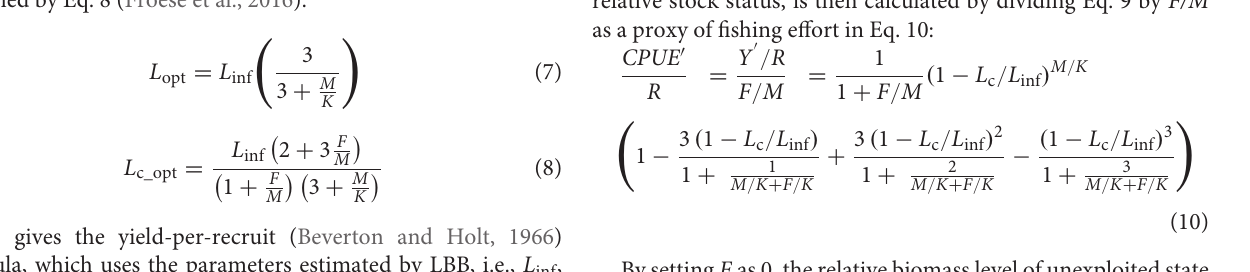
Eq. 7 (Holt, 1958) and the L c _ opt value that leads to L opt could